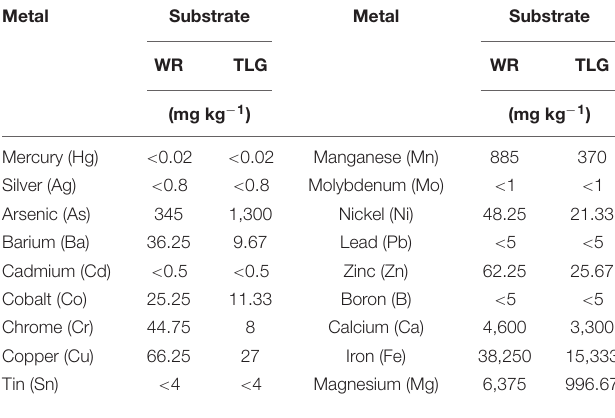
TABLE 2 | Trace element concentrations in soils from the two disturbed sites: waste rock stockpile (WR) and tailings